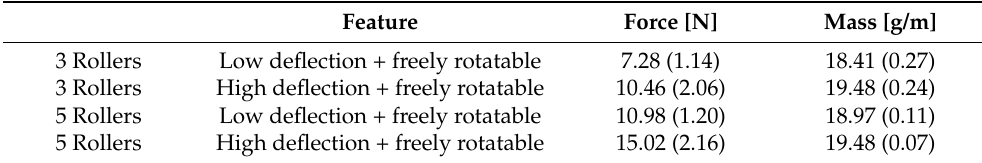
Table 5. Yarn pulling forces during processing and mass/length ratios of fresh MCF made with varied yarn deflection: average values, standard deviations in parentheses.